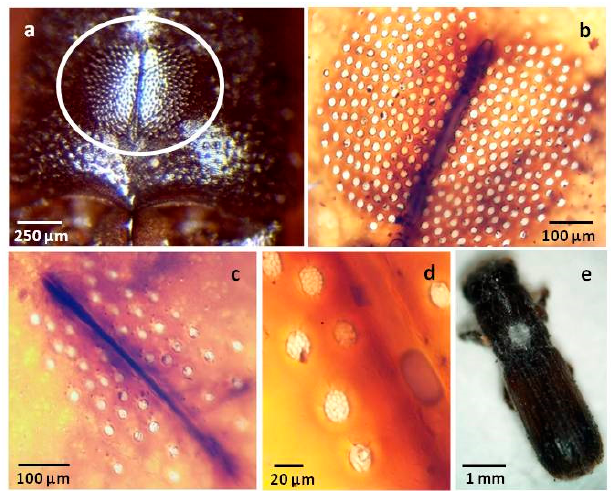
Figure 2. Mycangia of Platypus cylindrus : ( a ) female mycangia, ( b ) micrograph of female mycangia, ( c , d ) micrographs of male mycangia, ( d ) detail of integumentary pits filled with tightly packed spores of ambrosia fungi, ( e ) dying insect covered by the ambrosial mycelium coming out of the mycangia.